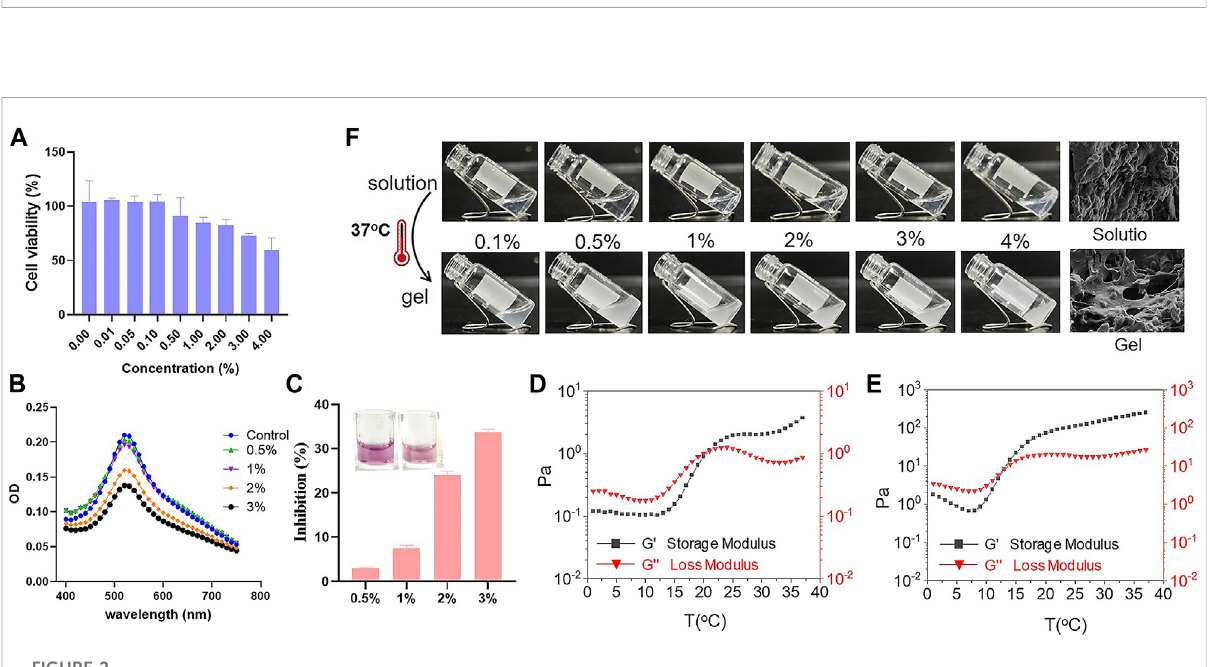
FIGURE 2 In vitro characterization of Se-PEG-PPG. (A) H9C2 cell viability after Se-PEG-PPG treatment; (B) Antioxidant activity of Se-PEG-PPG hydrogel assessed using DPPH; (C) The free radical scavenging rate of different concentrations Se-PEG-PPG measured at λ max of 520 nm using DPPH; (D) Rheological properties of 2% Se-PEG-PPG; (E) Rheological properties of 3% Se-PEG-PPG. Black and red represent storage modulus (G ′ ) and loss modulus (G ″ ), respectively; (F) In vitro gelation of Se-PEG-PPG hydrogel at 37 ° C and SEM images of Se-PEG-PPG hydrogel before and after gelation. Scale bar, 10 μ